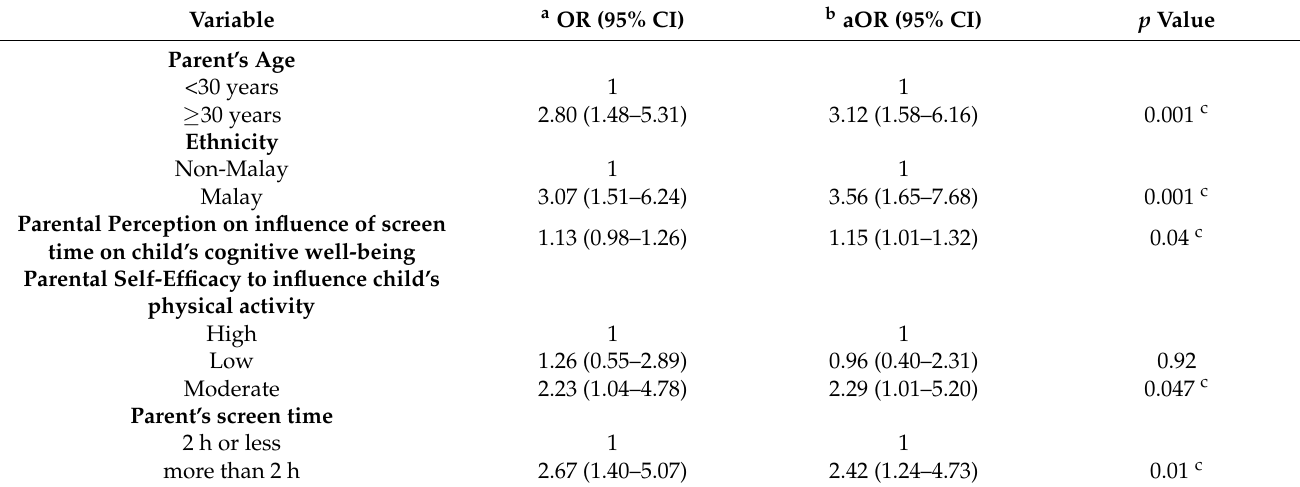
Table 3. Determinants of excessive screen time among children below five years of